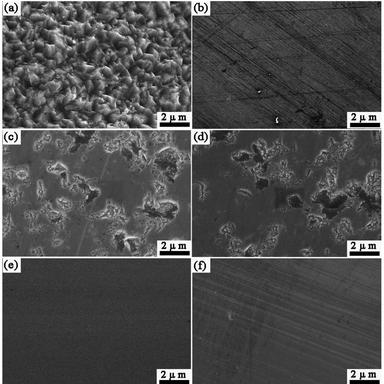
SEM images of 4H–SiC wafer surface before (a) after polishing using pristine ND (b), D@C-0.25 (c), D@C-0.5 (d), D@C-0.75 (e), and D@C-1.0 (f).